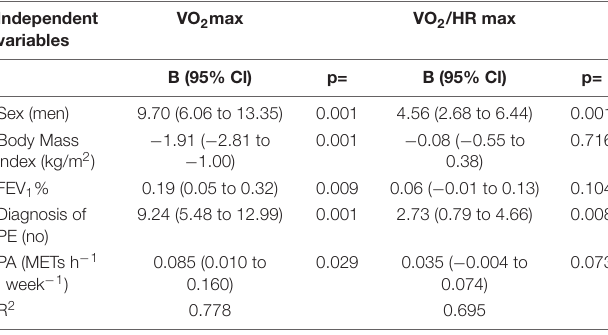
TABLE 4 | Predictors of VO 2 max, and VO 2 /HR max (dependent variables) at multivariable linear regression analysis.